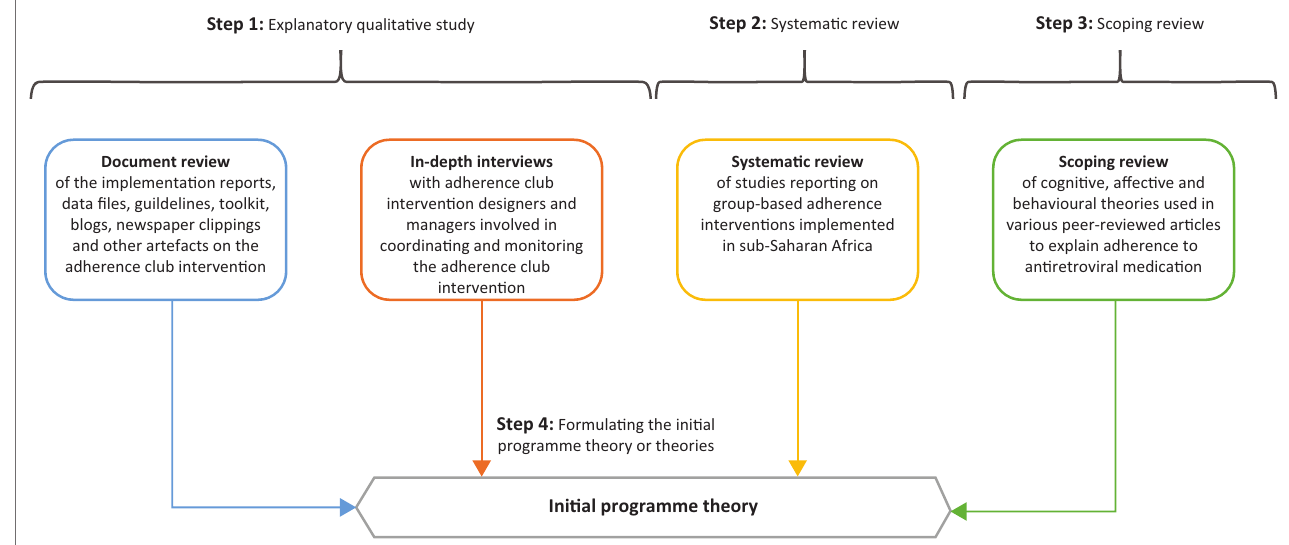
FIGURE 1: Sources of information towards formulating the initial programme